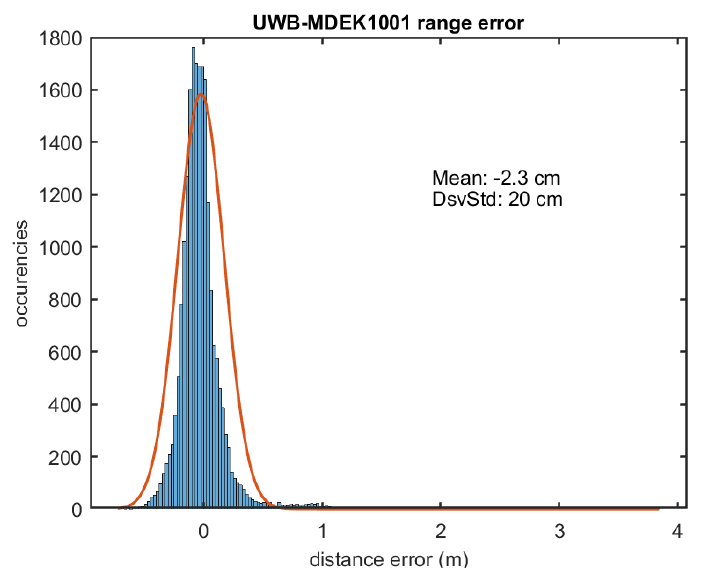
Figure 13. Errors in the measurement of ranges between eight anchors and four tags moving within our indoor lab space. Above: Measured vs. actual range. Below: error distribution, and overlap- ping